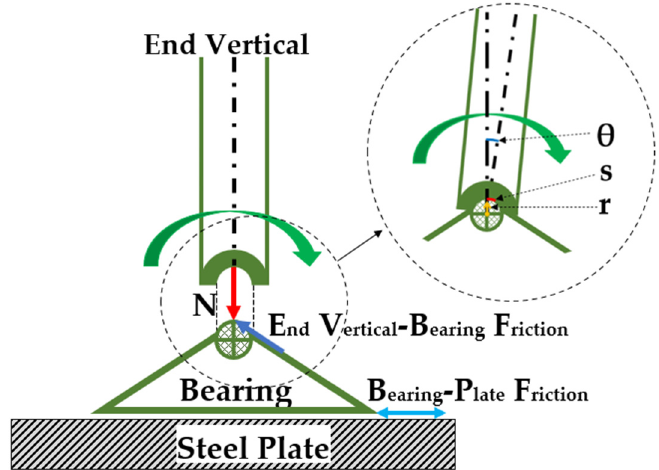
Figure 24. Bearing contact forces.